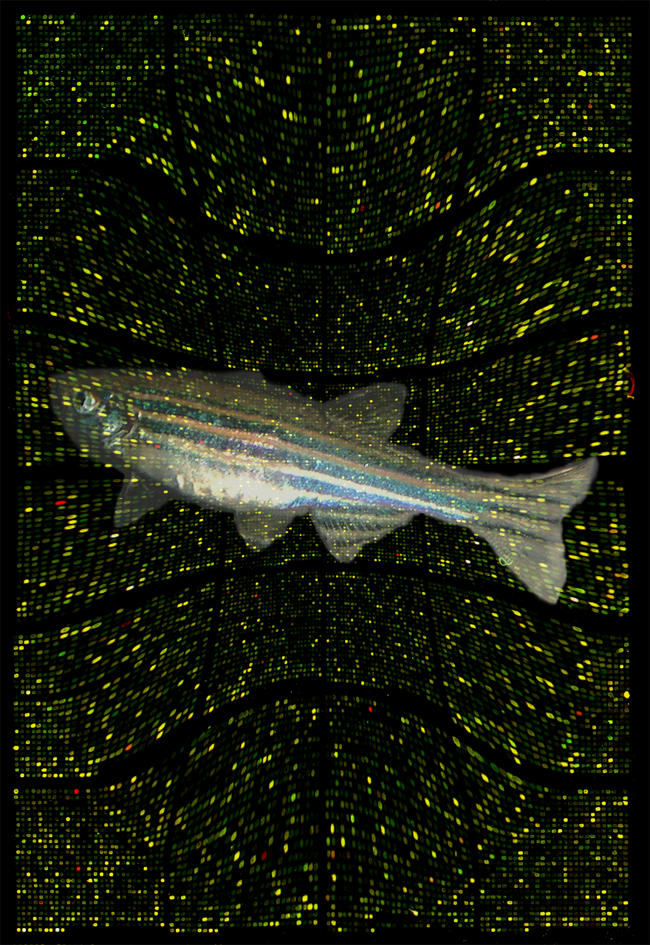
Using a zebrafish microarray, researchers discovered which human genes are active during hematopoiesis, the formation of blood cells